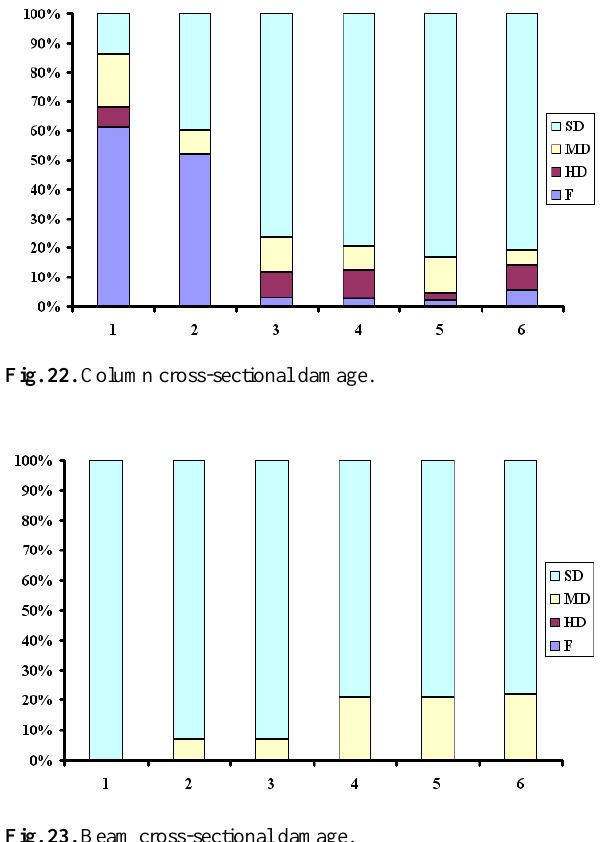
Fig. 23. Beam cross-sectional damage.